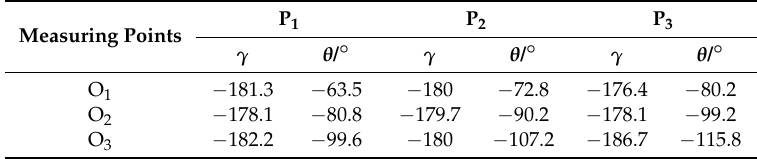
Table 3. The direction angles of the three measurement points when SNR=5 dB.